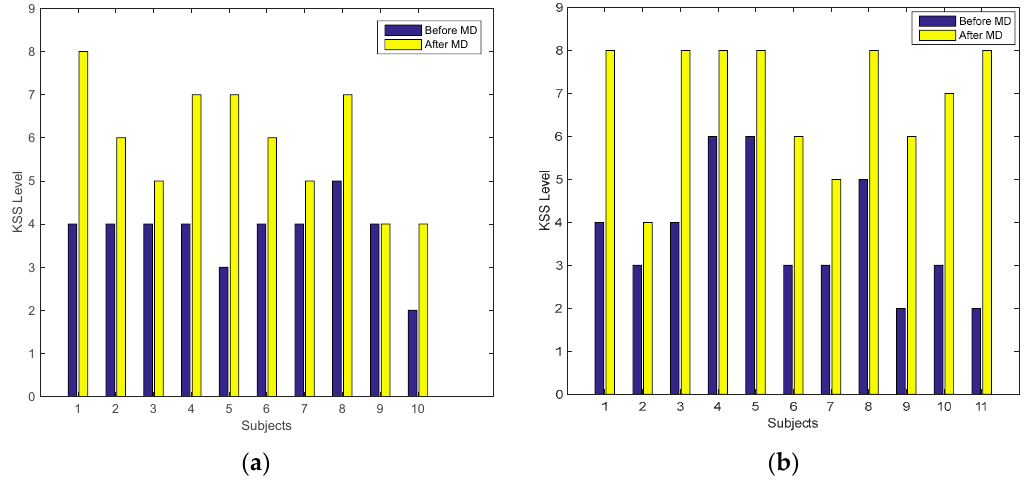
Figure 3. KSS rating of each subject before and after MD session in: ( a ) Alert group; ( b ) Drowsy group.